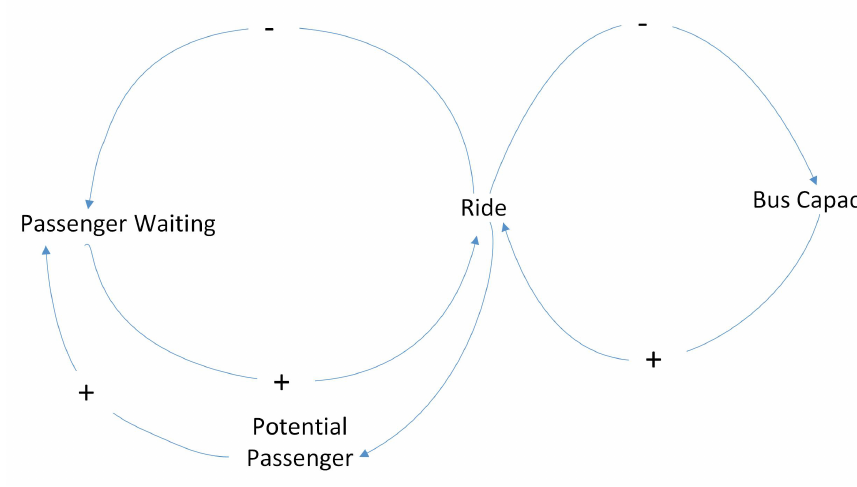
Figure 3. Casual Loop.